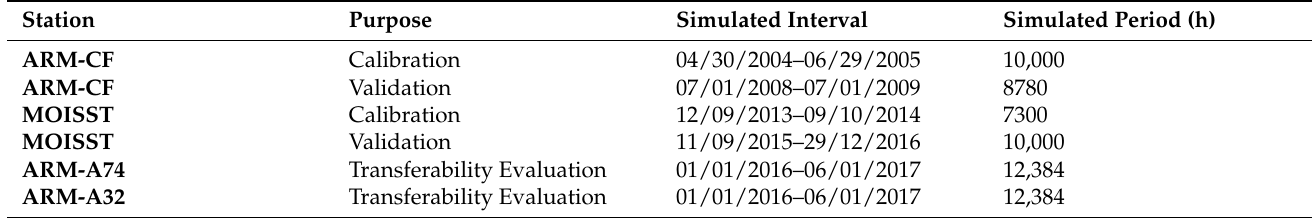
Table 4. Selected time periods for tRIBS model calibration, validation, and parameter transfer assessment.